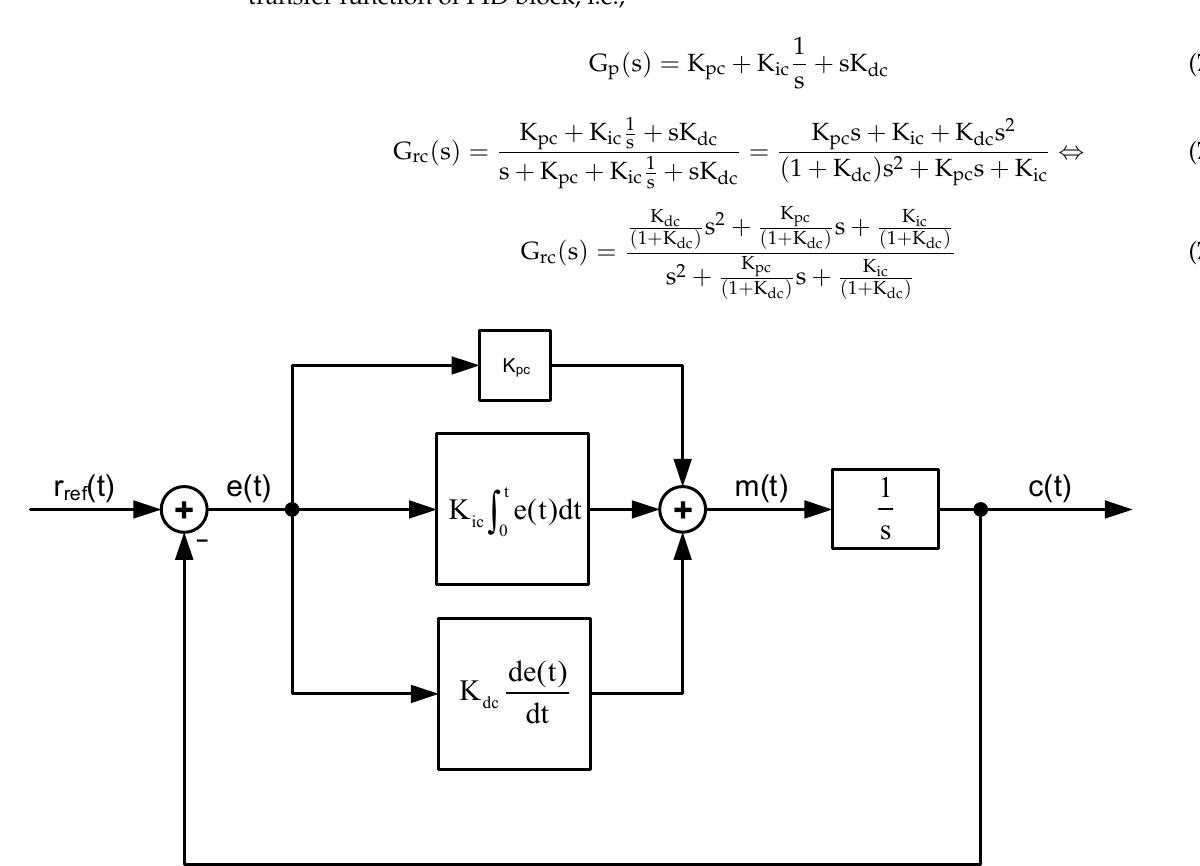
Figure 20. Continuous-time analogous to our control system core.